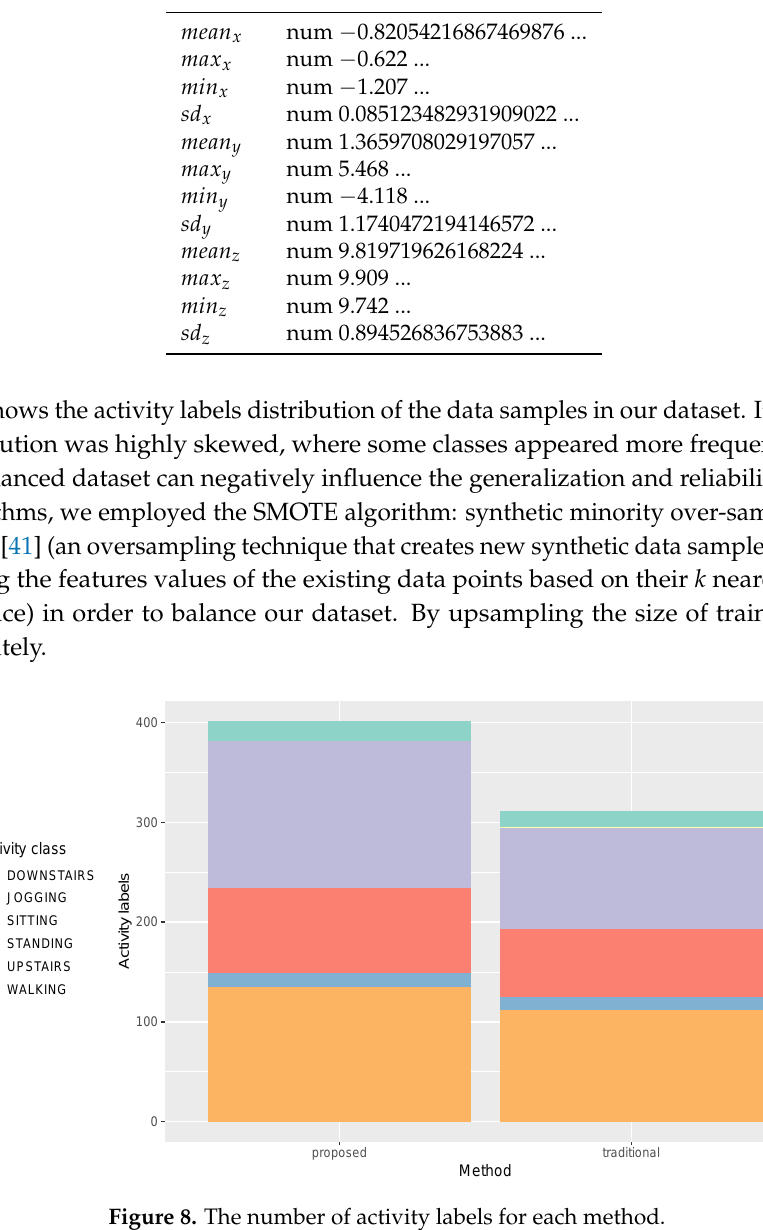
Figure 8. The number of activity labels for each